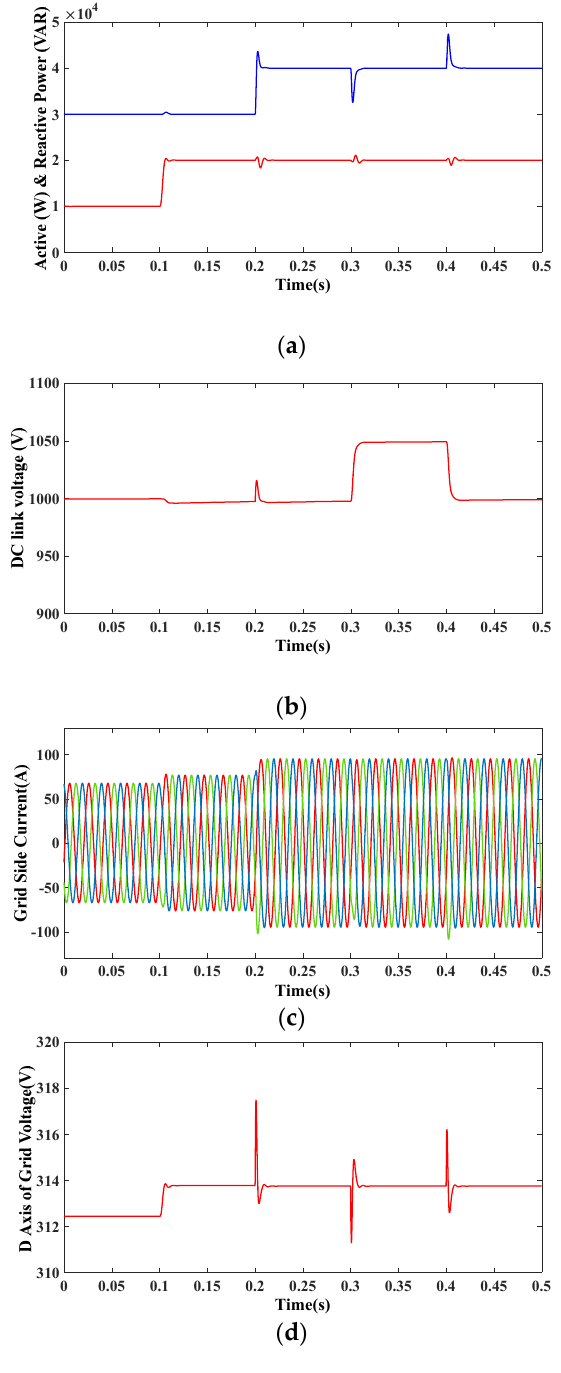
Figure 10. Response of the simulated system with 𝐿 (cid:3046) = 0.4 mH , 𝐿 (cid:2869) = 0.9 mH , and 𝐿 (cid:2870) = 0.48 mH ; ( a ) the active and the reactive powers, ( b ) the DC-link voltage, ( c ) grid-side currents, and ( d ) PCC volt- age magnitude.